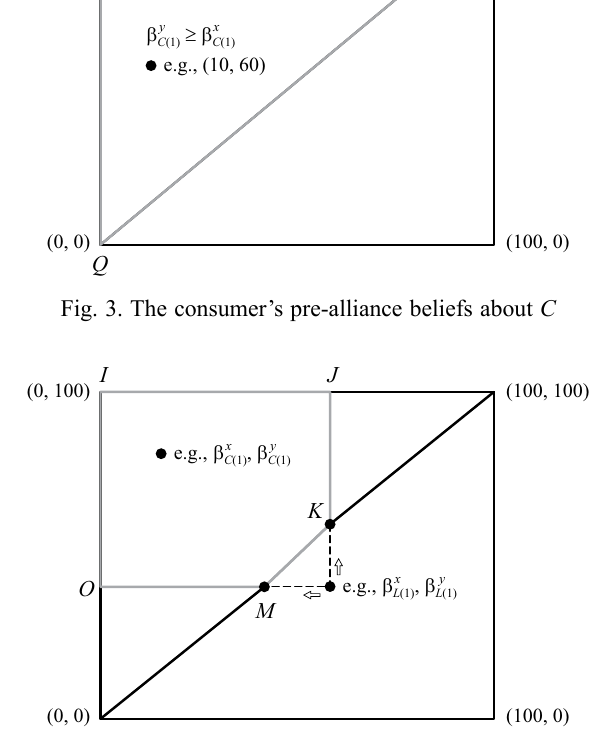
Fig. 4. The consumer’s pre-alliance beliefs about L and